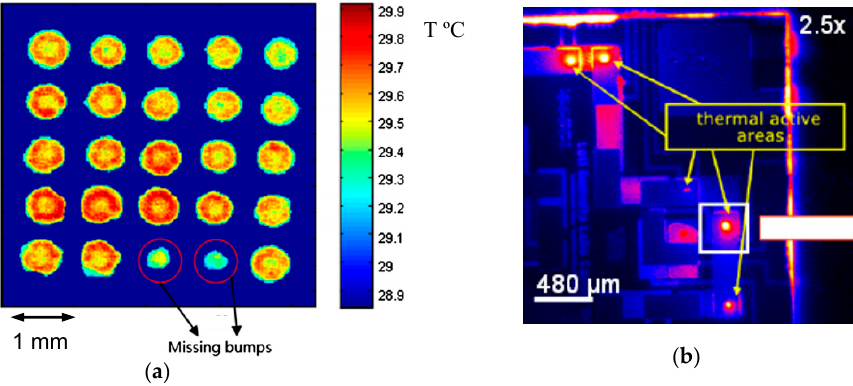
Figure 14. Defect detection using infrared thermography method: ( a ) missing bumps with lower temperature [33] and ( b ) failed device emitting increased heating [92].